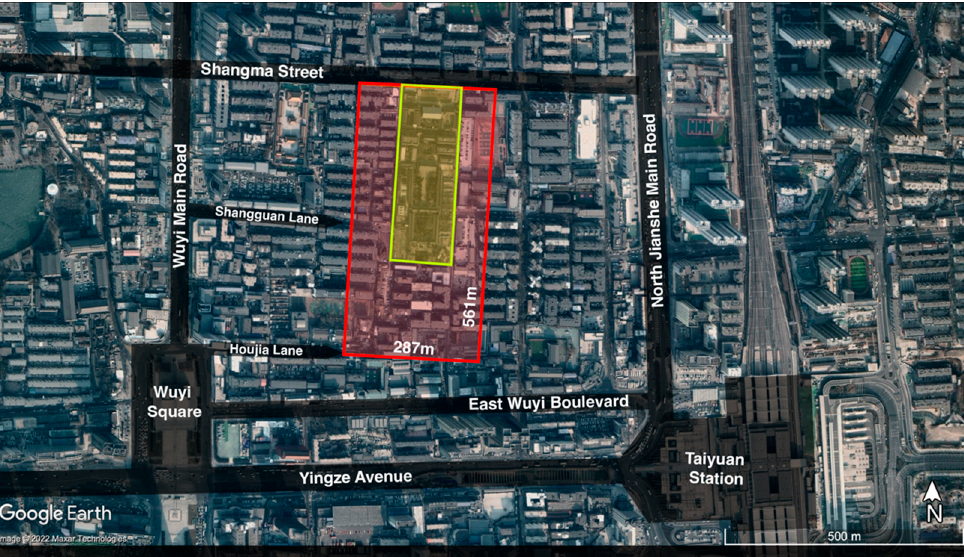
Figure 8. Estimated scope of Chongshansi in Taiyuan (drawing by author, based on Google Maps, 2022).